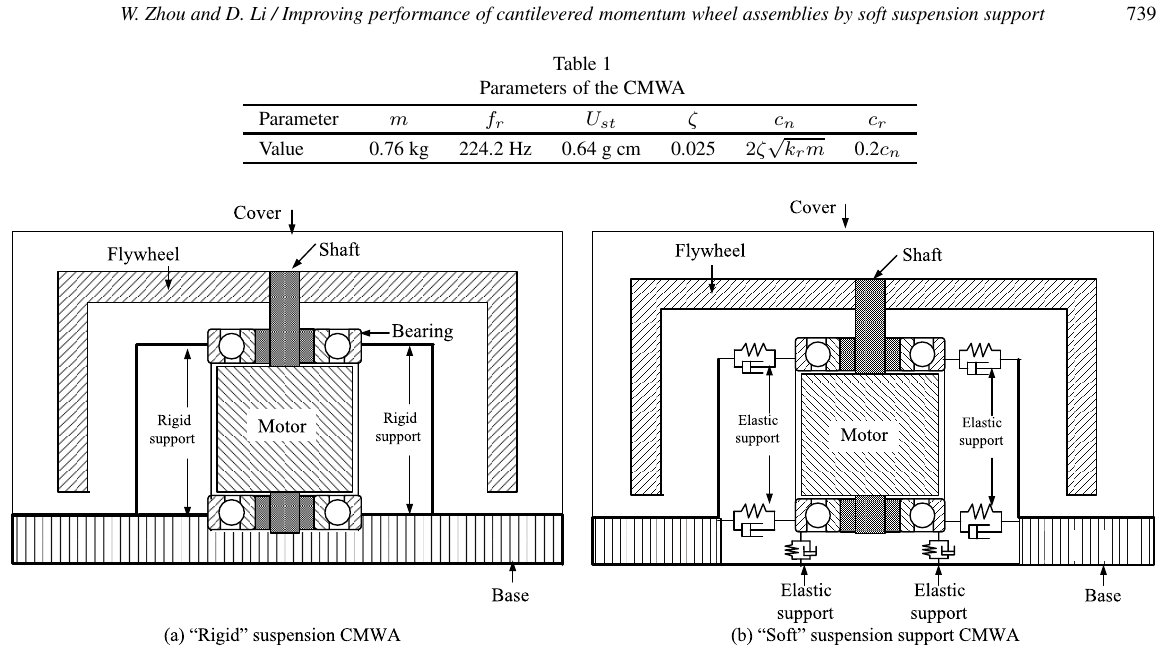
Fig. 1. The “rigid” support and “soft” suspension